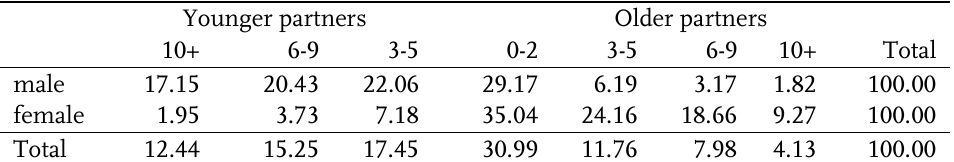
Table 2 : Age differences (categorized) by gender Younger partners